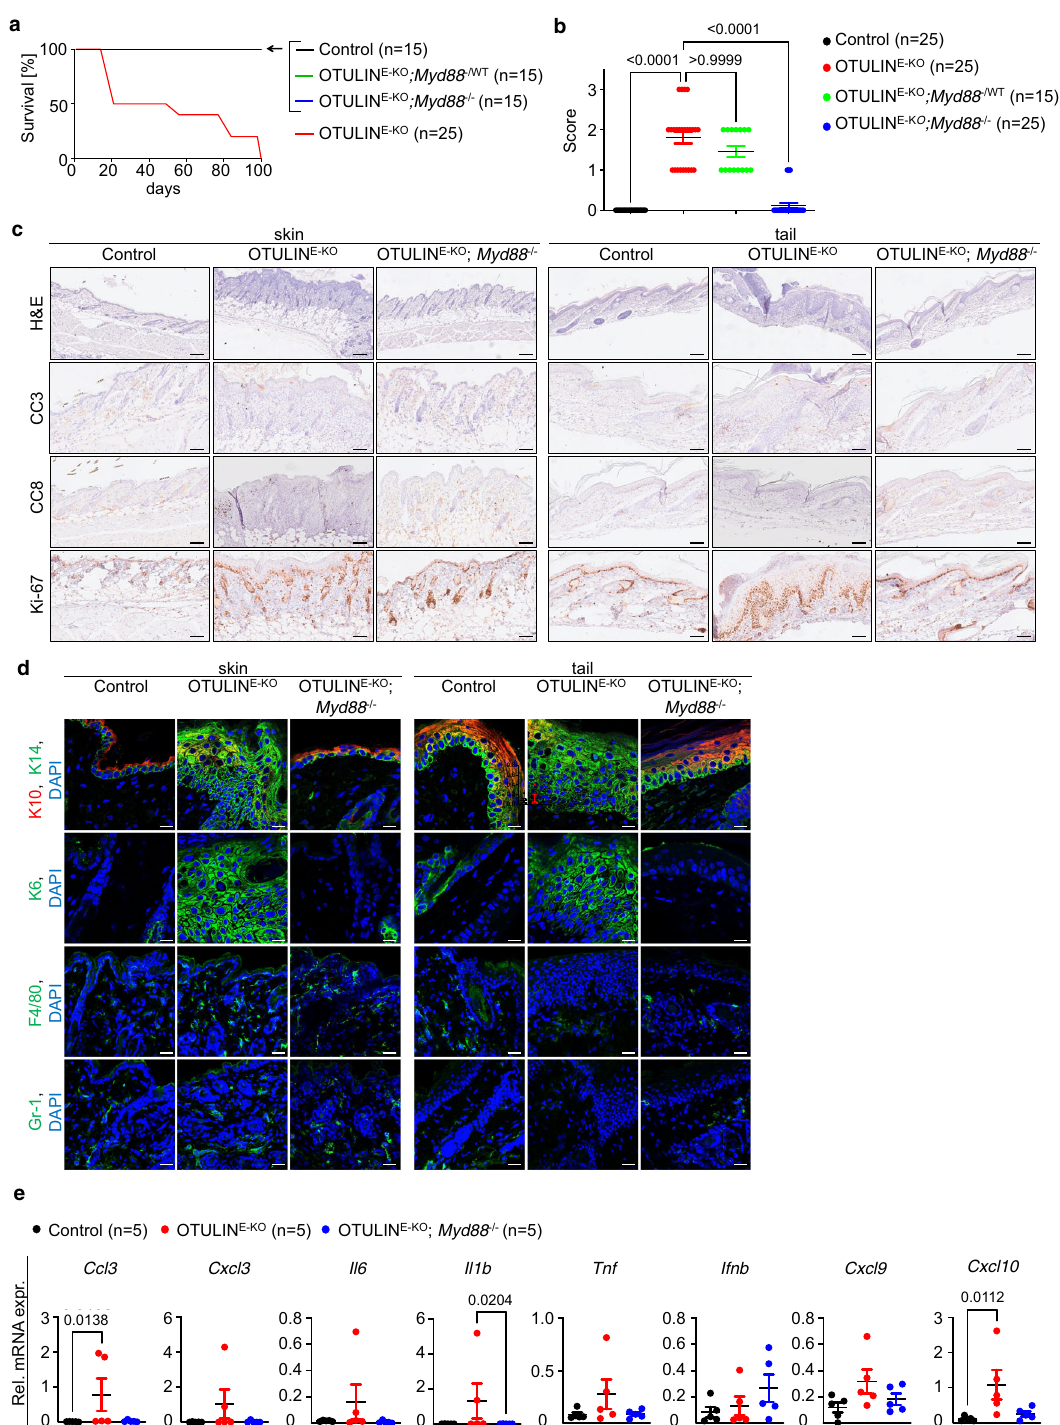
Fig. 8 MyD88-dependent signalling contributes to the development of skin pathology in OTULIN E-KO mice. a Kaplan – Meier plot depicting survival of mice of the indicated genotypes. b Graph depicting macroscopic skin score of mice of the indicated genotypes. The dots in the graphs represent individual mice. Mean ± s.e.m. is shown for each group of mice in all graphs. Statistical signi fi cance was determined using Kruskal – Wallis test (one-sided). c Representative images from skin sections from 3-week-old mice of the indicated genotypes, stained with H&E ( n = 5) or immunostained with anti-CC3 ( n = 5), anti-CC8 ( n = 5) or anti-Ki-67 ( n = 5) antibodies. Scale bars: H&E = 100 μ m; CC3, CC8, Ki-67 = 50 μ m. d Representative images from skin sections from 3-week-old mice of the indicated genotypes, immunostained with anti-K10, anti-K14 ( n = 5), anti-K6 ( n = 5), anti-F4/80 ( n = 5) and anti-Gr- 1 ( n = 5) antibodies and counterstained with DAPI (DNA stain). Scale bars: K10, K14, K6 = 20 μ m; F4/80, Gr-1 = 30 μ m. e Graphs depicting relative mRNA expression of the indicated genes in RNA from whole-skin tissue of 3-week-old mice of the indicated genotypes, measured by qRT-PCR. The dots in the graphs represent individual mice. Mean ± s.e.m. is shown for each group of mice in all graphs. Statistical signi fi cance was determined using Kruskal – Wallis test (one-sided). Control mice include littermates that do not express K14-Cre . Source data for a , b , e are provided as a Source data fi